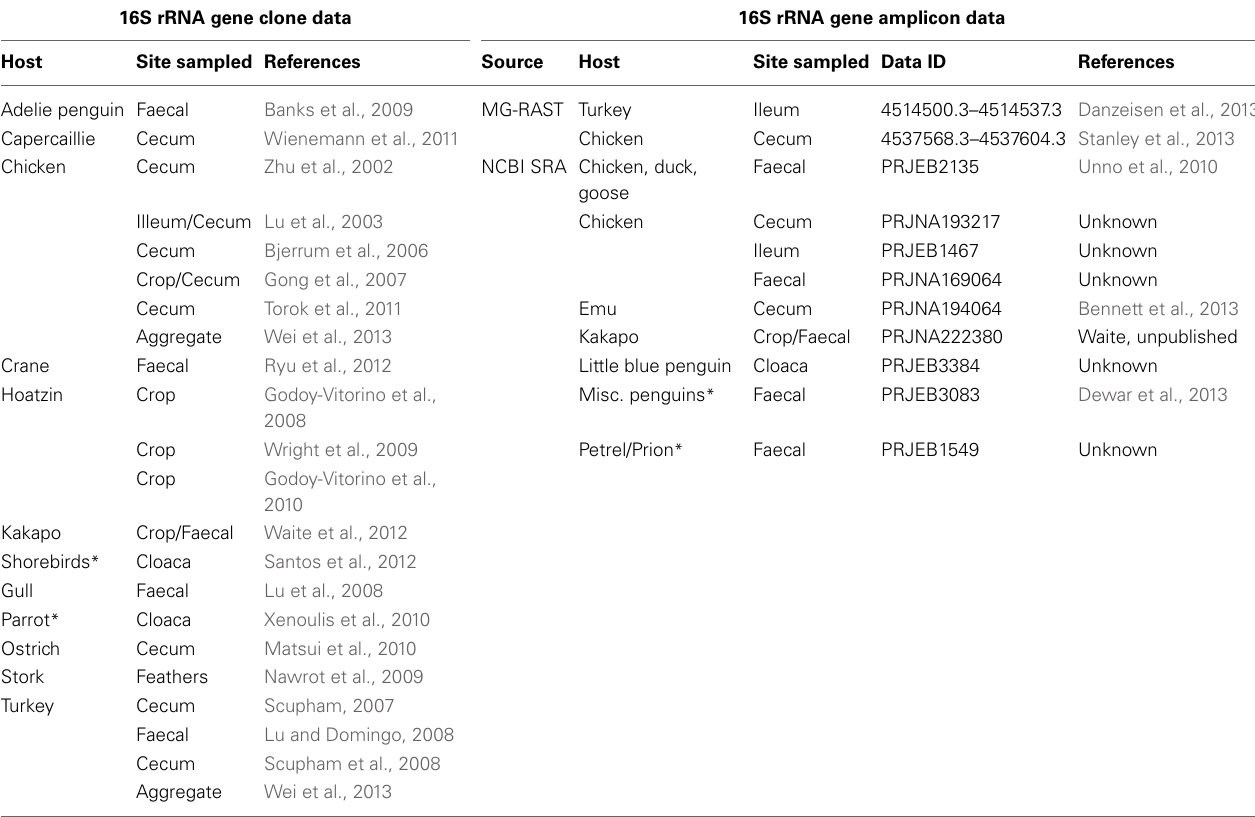
Table 1 | Published sequence data obtained from molecular analysis of avian samples. 16S rRNA gene clone